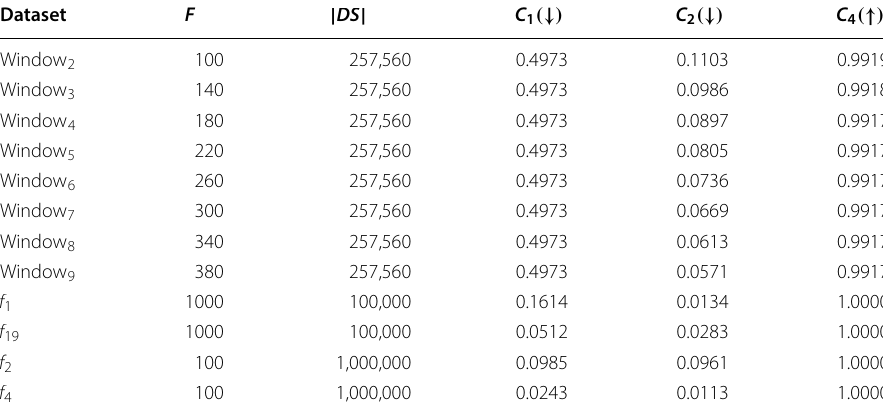
Table 1 Properties of the real-world and synthetic datasets